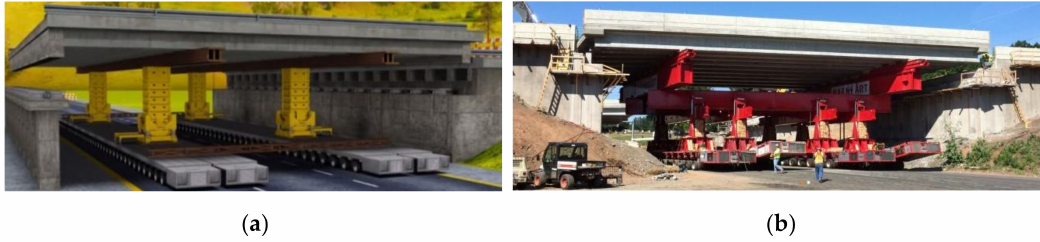
Figure 8. ( a ) Illustration of placing a new bridge deck with the use of an SPMT (computer-controlled platform vehicles) with jack-ups [19]; ( b ) placing a bridge with an SPMT during the replacement project, I-84 bridges over Marion Avenue in Southington, US